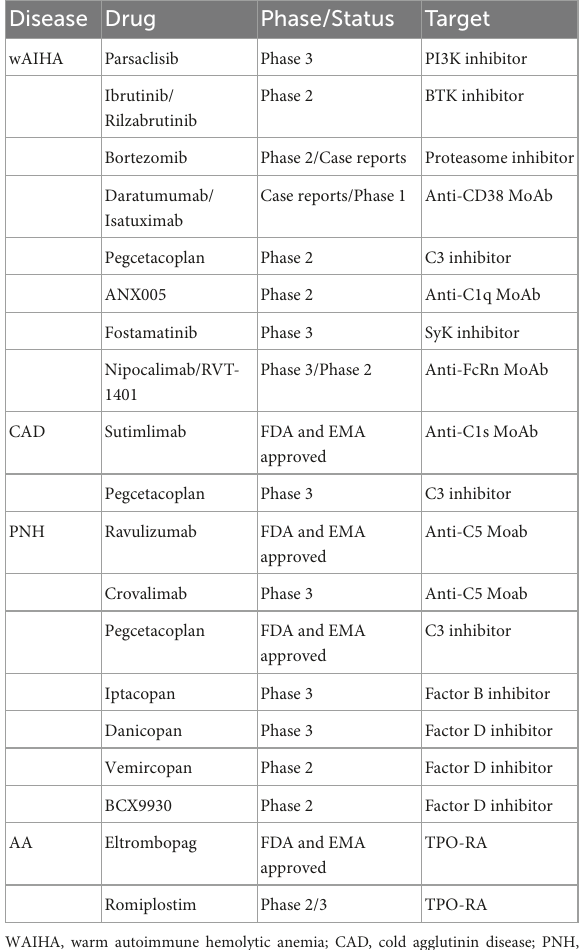
TABLE 2 Novel drugs in patients with rare, acquired anemias. Disease